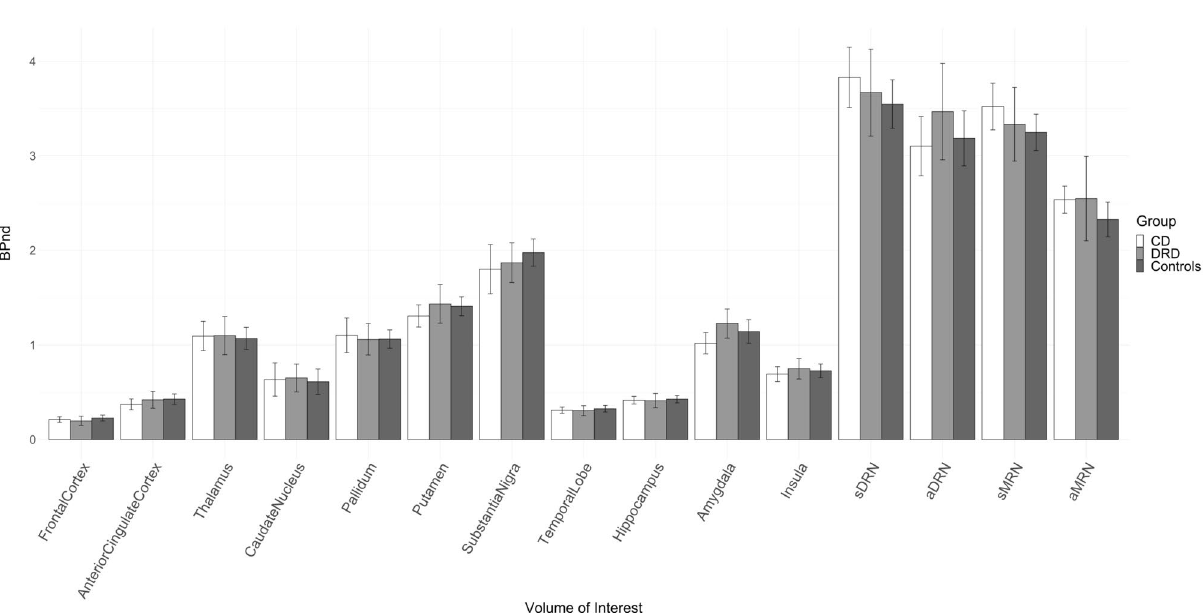
Figure 2. Non-displaceable binding potential ( BP ND ) per VOI. Data presented as mean with 95% confidence interval as error bar. No significant differences in any region between the groups were found. CD